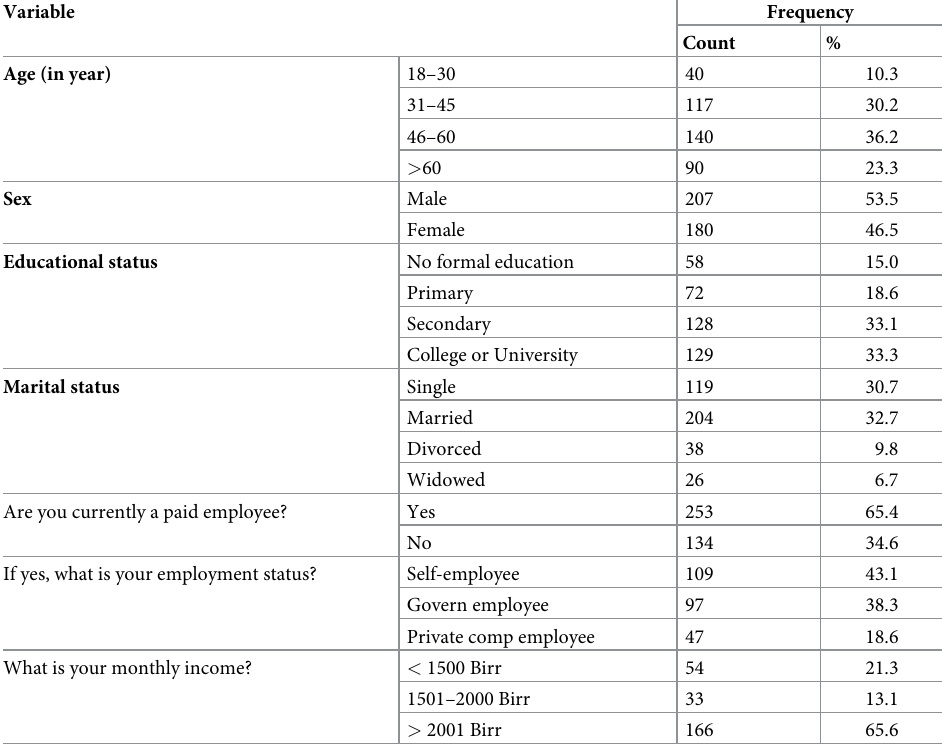
Table 2. Socio-demographic characteristics of hypertensive patients on treatment follow up regarding lifestyle modification at Yekatit 12 General hospital in 2019 (n = 387).